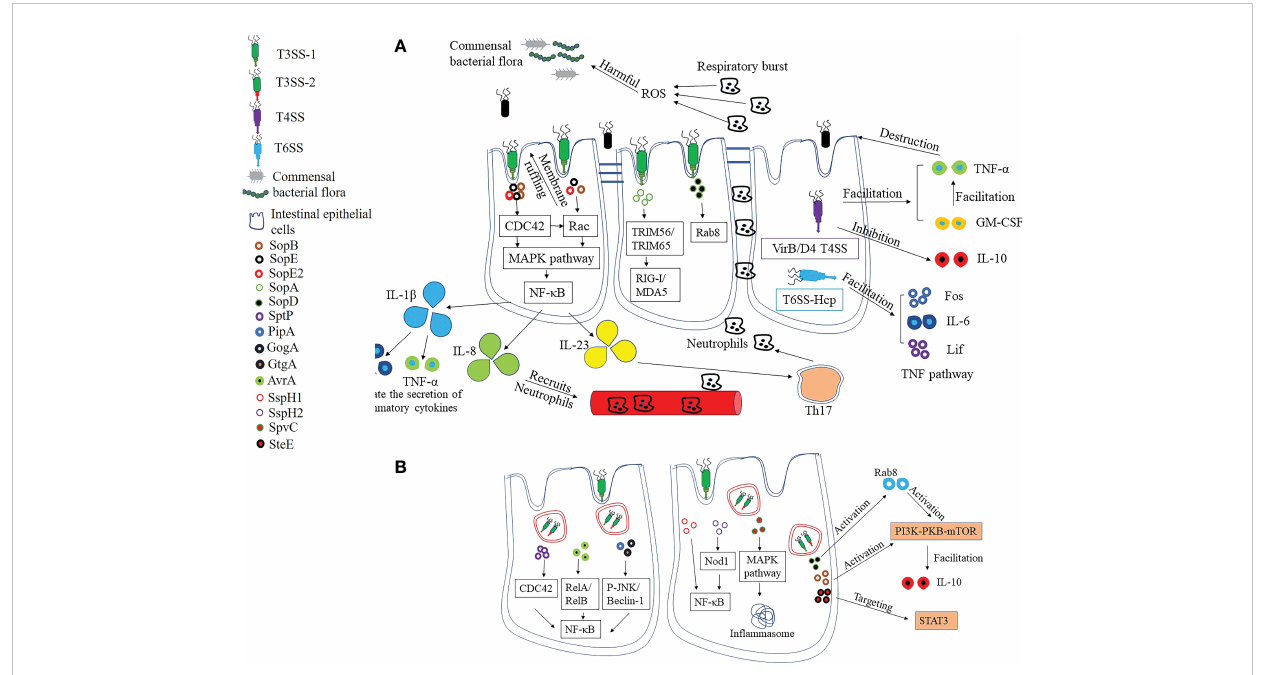
FIGURE 2 Pro-in fl ammatory and anti-in fl ammatory strategies of Salmonella . (A) Pro-in fl ammatory strategies. The effector proteins SopB, SopE and SopE2 secreted by T3SS are the central components of pro-in fl ammatory response, which leads to pro-in fl ammatory cytokine release by facilitating the activation of NF- k B. The production of pro-in fl ammatory cytokines recruits neutrophils, which contributes to the destruction of intestinal commensal fl ora and promotes Salmonella colonization. SopA and SopD, meanwhile, target innate immune in fl ammatory signals to stimulate in fl ammation and contribute to the ampli fi cation of the in fl ammatory response. T4SS-containing Salmonella can suppress the anti-in fl ammatory cytokine IL-10 secretion while increasing TNF- a and GM-CSF levels, resulting in intestinal epithelial barrier dysfunction and disruption of integrity. Hcp, one of the structural and effector proteins of T6SS, is involved in the regulation of TNF signaling pathways, including upregulation of Fos, IL-6 and Lif levels. (B) Anti-in fl ammatory strategies. The excessive in fl ammatory response leads to epithelial cell death, which in turn affects Salmonella survival. SptP, the effector protein of Salmonella , can inhibit in fl ammation by limiting the activity of CDC42. There are also some effector proteins that can affect NF- k B activation, which in turn reduces the pro-in fl ammatory response. In addition, the host mitogen-activated protein kinase (MAPK) is inactivated by SpvC, which also inhibits host autophagy and prevents the formation of in fl ammasome. SopB and SopD can stimulate the PI3K-PKB-mTOR signaling pathway, respectively, which inhibits the in fl ammatory response. Finally, the SteE (GogC) protein targets STAT3, a signaling pathway that restores homeostasis after an in fl ammatory